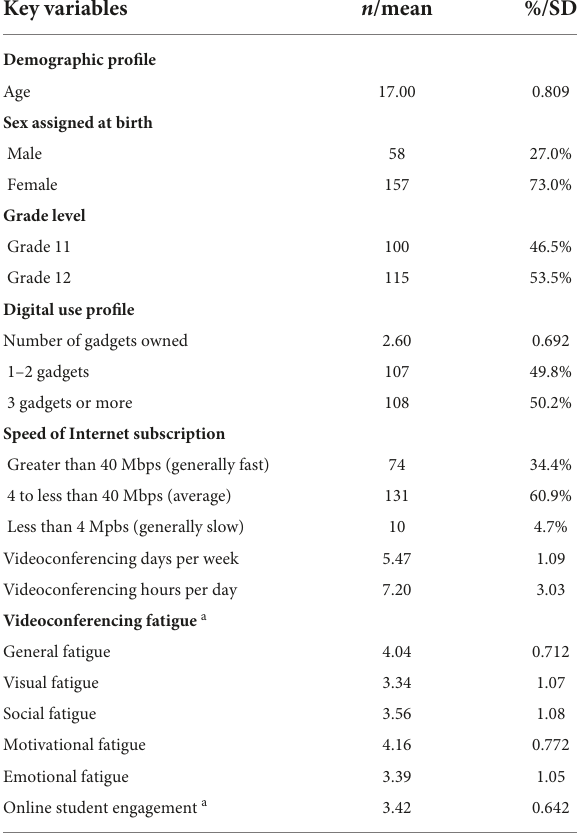
TABLE 1 Descriptive statistical results of key variables ( N =